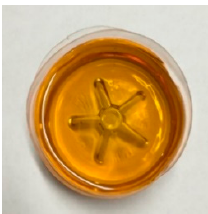
Figure 3. Filtered waste cooking oil (WCO).